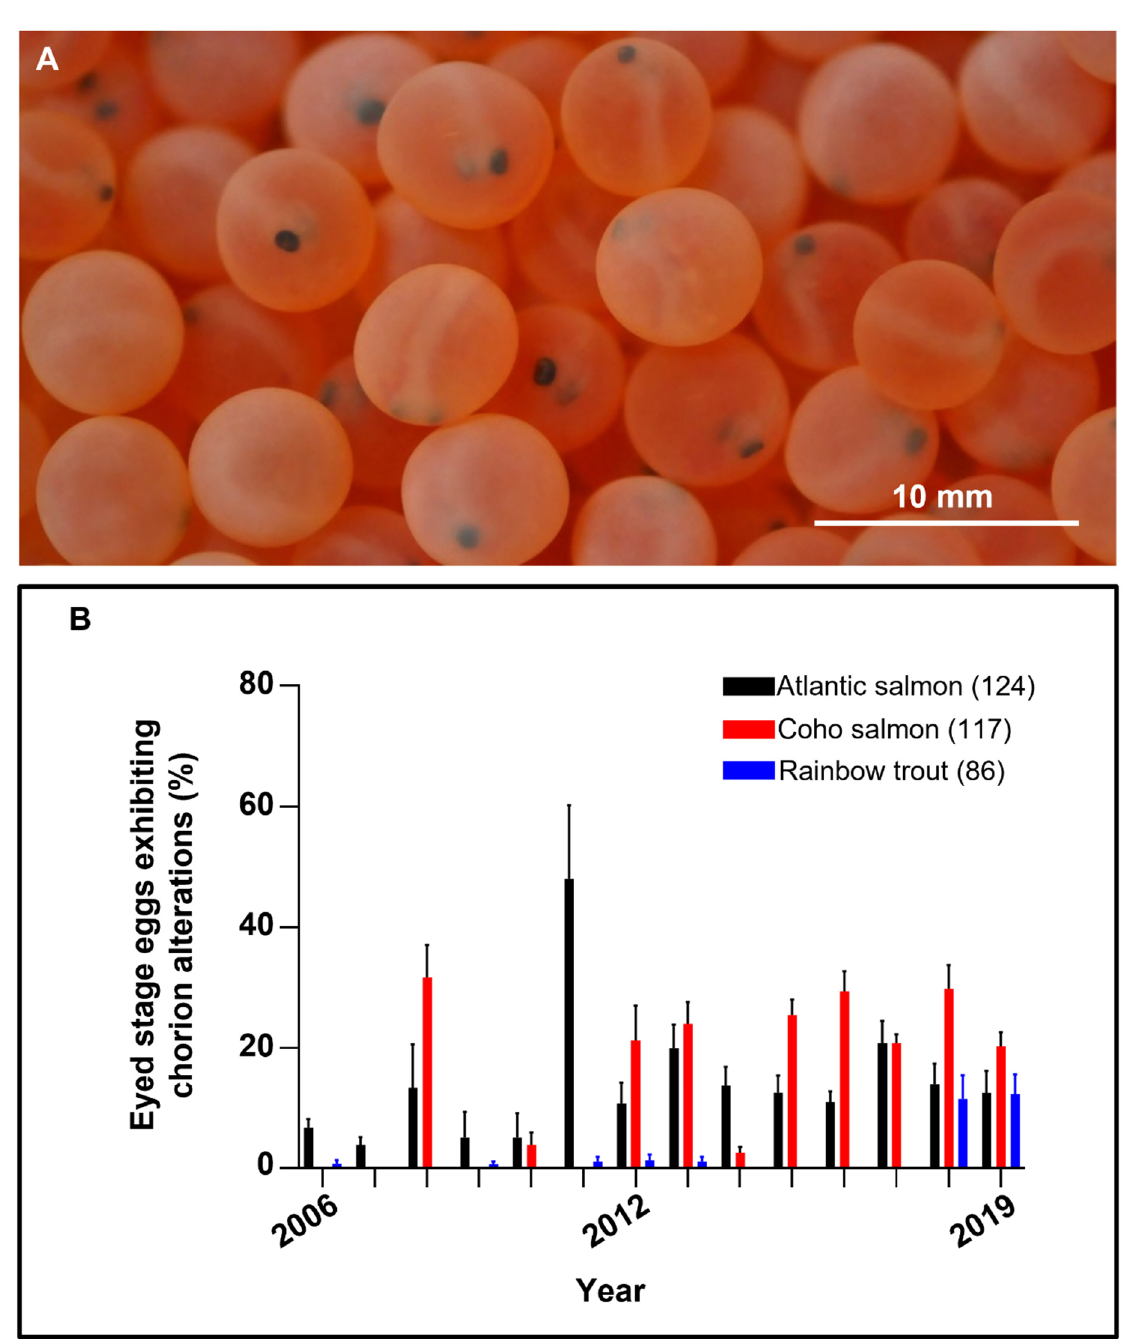
Figure 1. Occurrence of altered chorion in eyed-eggs. ( A ) Representative example of live (Coho Salmon) eyed-stage embryos after mechanical shocking and removal of dead and infertile eggs in which the ( B ) occurrence of chorion alterations were analyzed. Data are means + SEM. Total number of females analyzed in the year series in brackets; twenty eggs per female were analyzed.